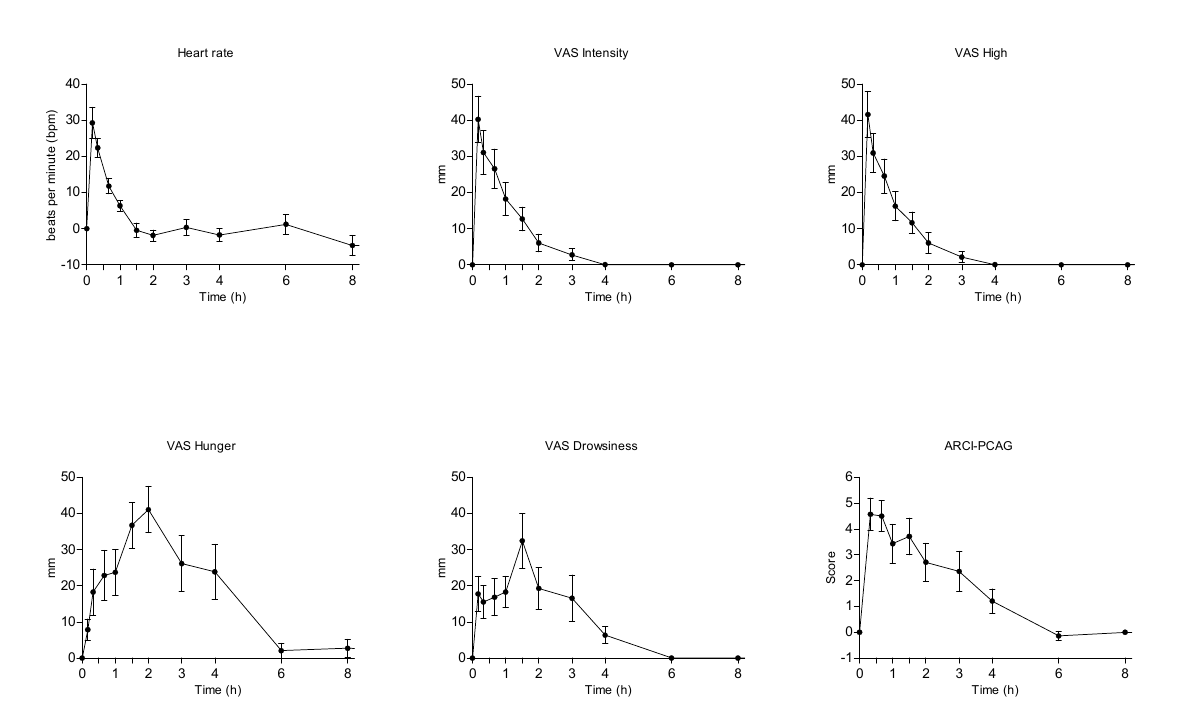
Figure 7. Mean time-course of physiological and subjective mostly modified effects in healthy volunteers administered with 100 mg vaporized cannabis. Table 3. Physiological and subjective effects in healthy volunteers administered with 100 mg vaporized medical cannabis.